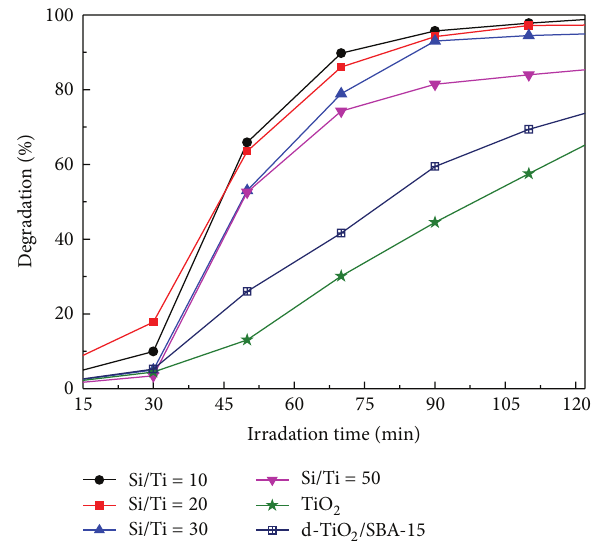
Figure 6: Photocatalytic degradation of Ti-SBA-15 to phenol under different Si/Ti ratio. d-TiO 2 /SBA-15 is TiO 2 deposited directly into pre-synthesized SBA-15.